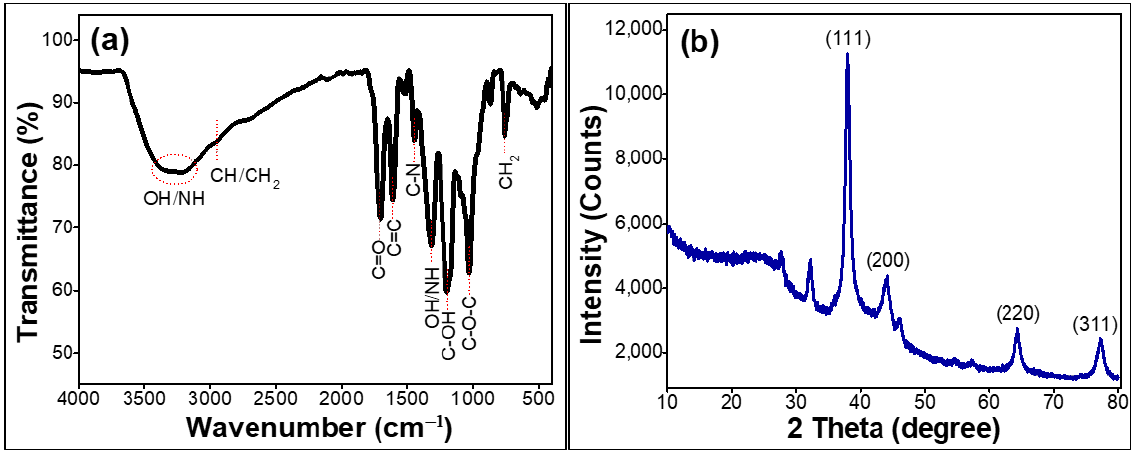
Figure 2. ATR-FTIR and XRD studies of AgNPs. ( a ) ATR-FTIR spectrum and ( b ) XRD pattern of prepared AgNPs.